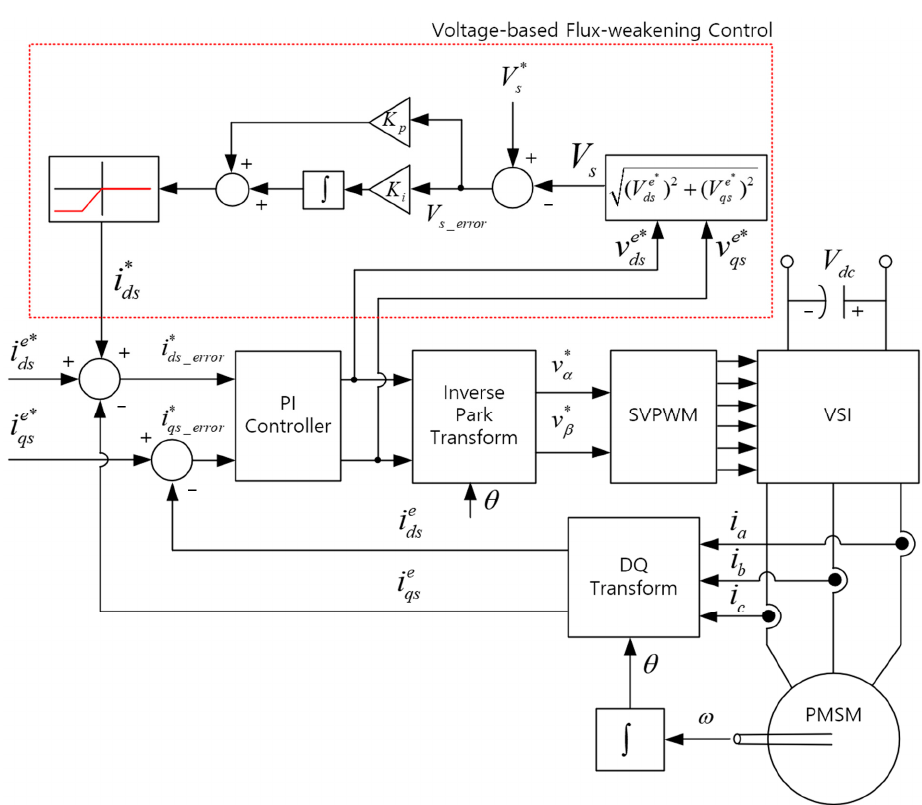
Figure 1. Block diagram of typical voltage-based flux-weakening control.